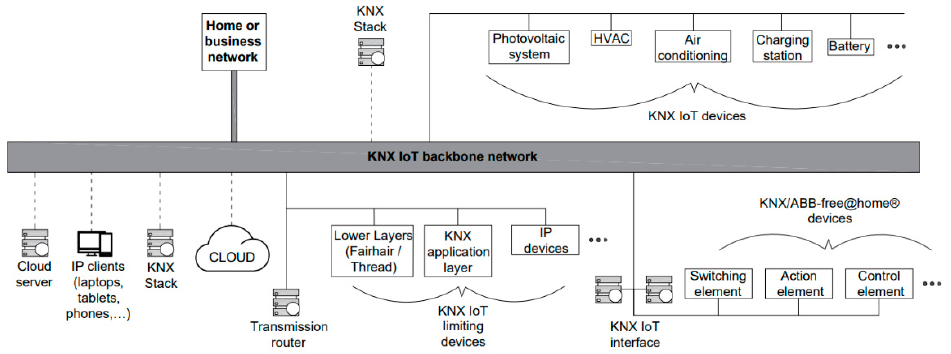
Figure 13. Model design of building automation in IoT application.